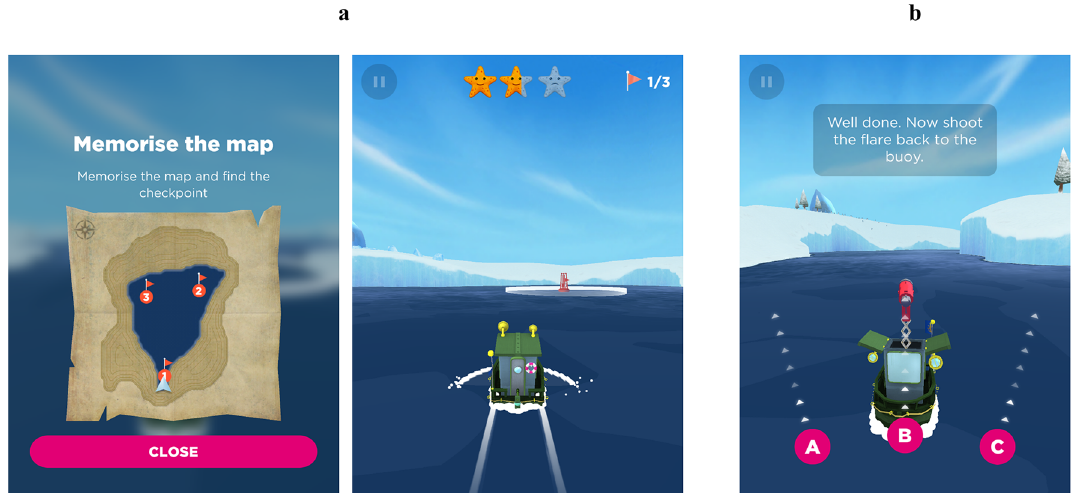
Figure 2. Illustration of SHQ. ( a ) Wayfinding level 6, where locations of three numbered checkpoints are first shown on a map. After the map disappears, participants have to navigate the boat to the numbered checkpoints in order, ( b ) Flare level 9, where participants navigate the boat from a starting location along the river, until they find a flare gun. Once found, the boat rotates by 180° clockwise and the participants are asked to shoot the gun in the direction of the starting location. Adapted from 59